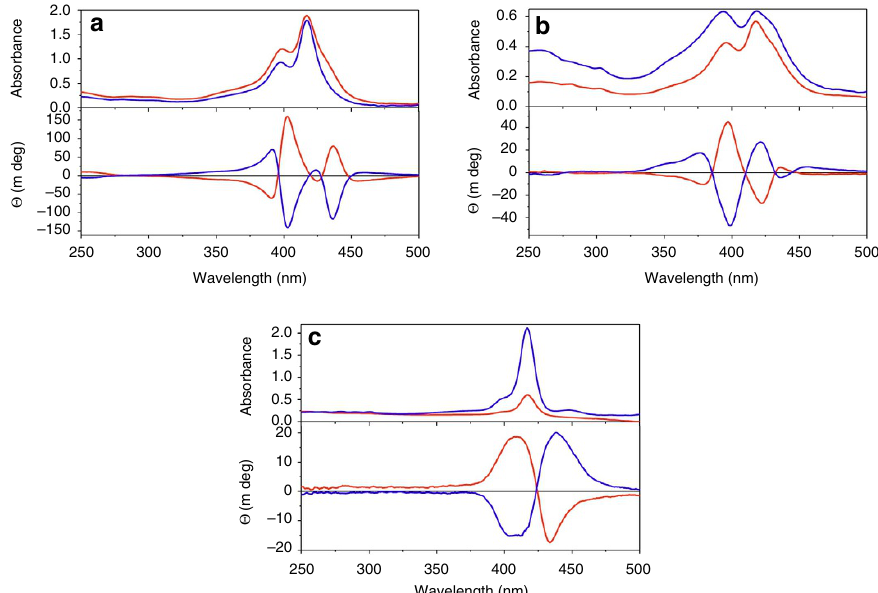
Figure 3 | Ultraviolet-Vis absorption and ECD spectra. Blue traces are from the natural dipeptide conjugate X-F L F L -TPP while red traces are from X-F D F D -TPP with X ¼ Boc ( a ) and X ¼ Fmoc ( b , c ). ( a ) Self-assemblies obtained by injecting 3 m l of Boc-FF-TPP from a stock solution (2.8mg dissolved in 350 m l dry dichloromethane) into dry n -heptane (400 m l). ( b ) Self-assemblies obtained by injecting 3 m l of Fmoc-FF-TPP from a stock solution (2.8mg dissolved in 330 m l dry dichloromethane) into dry n -heptane (400 m l). ( c ) Film on the cuvette walls from the same cuvette as in b after decanting the solution. Supplementary Fig. 20 presents the corresponding spectra of unprotected FF-TPP